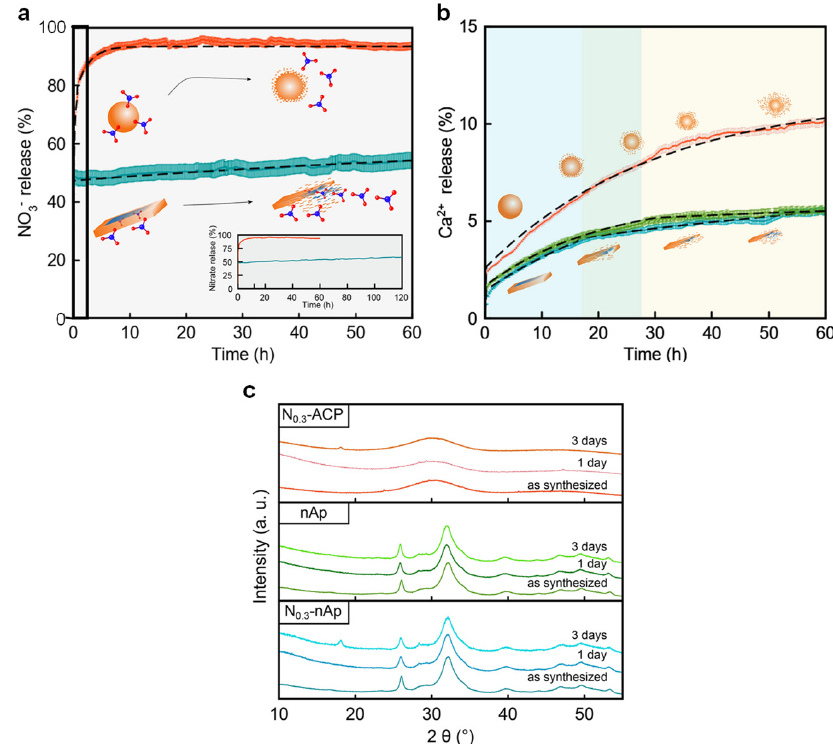
Figure 3. Cumulative release of nitrate ( a ) and calcium ( b ) from nitrate-doped nano-apatite (blue curve) and ACP (red curve) and non-doped nano-apatite (green curve); ( c ) Structural evolution of nitrate-doped nano-apatite, apatite and ACP nanoparticles after their suspension in water during days 1 and 3. “Adapted with permission from Ref. [26]. 2020, Springer Nature”.